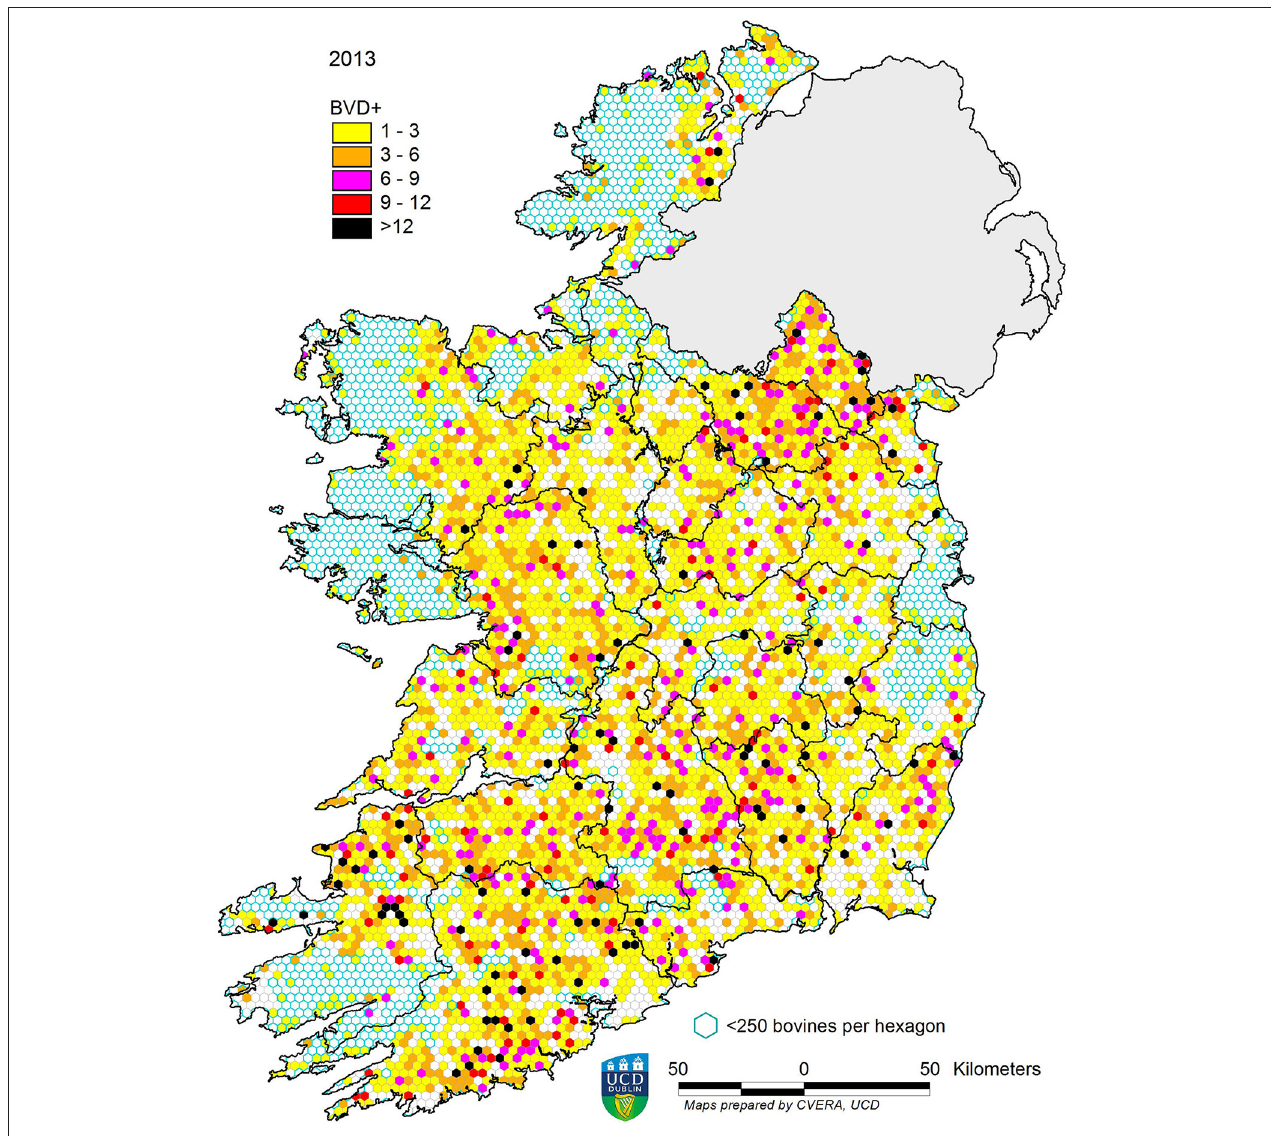
FIGURE 4 | Distribution of BVD + calves born in 2013. Each hexagon ∼ 10 km 2